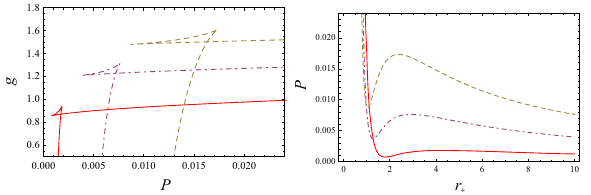
Fig. 4 The g – P ( left panel ) and P – r + ( right panel ) diagrams for T < T c .The threelines correspondto k = 1( dashedline ), k = 0( dotdashed line ) and k = − 1 ( solid line )